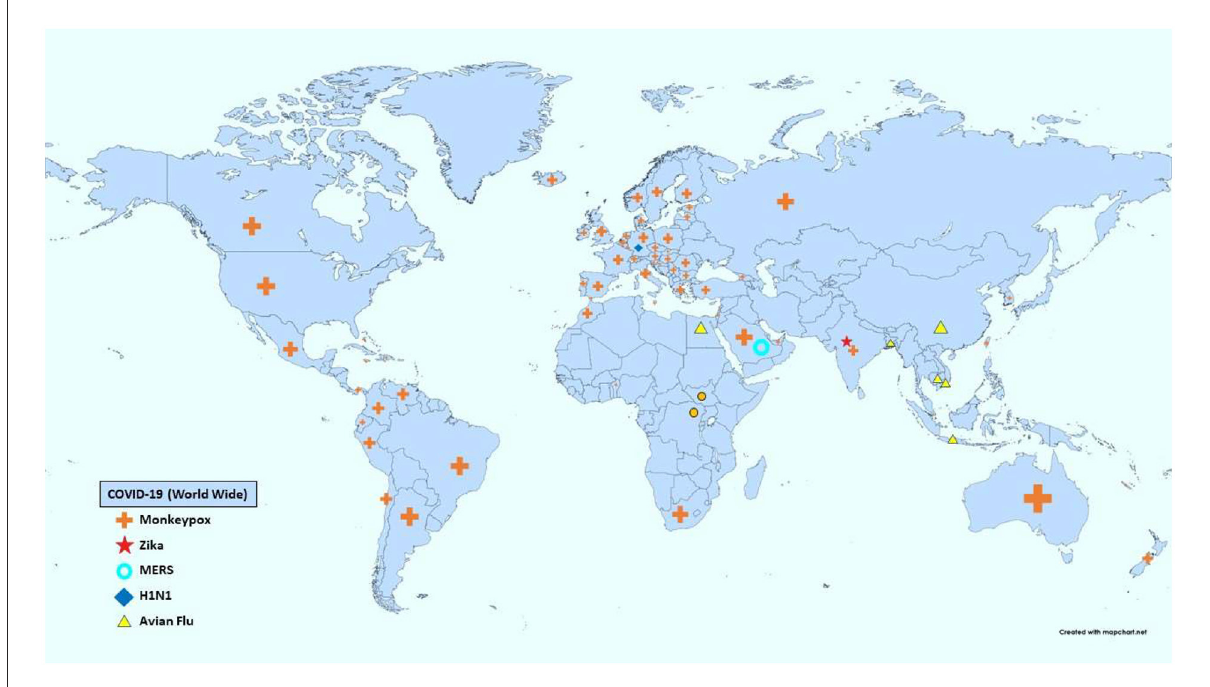
FIGURE1 Distribution of viral activity of each pandemic worldwide